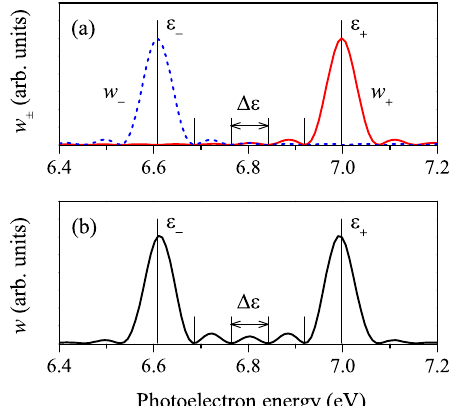
Figure 5. (Color online) ( a ) Partial distributions w ± ( ε ) and ( b ) total distribution w ( ε ) given by Equations (23) and (24), respectively, for the rectangular laser pulse with N = θ / ( 2 π ) =